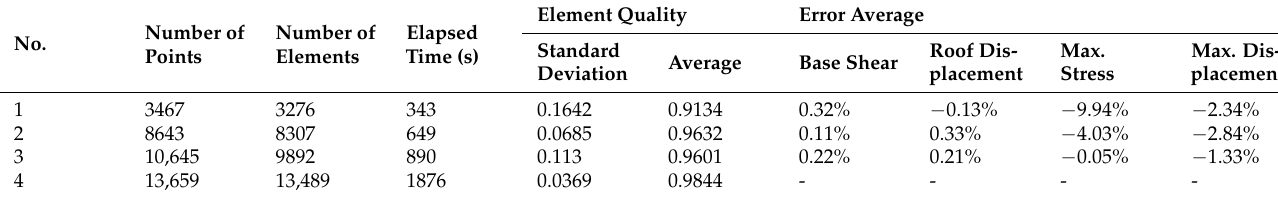
Table 2. Sensitivity analyses of SC6T